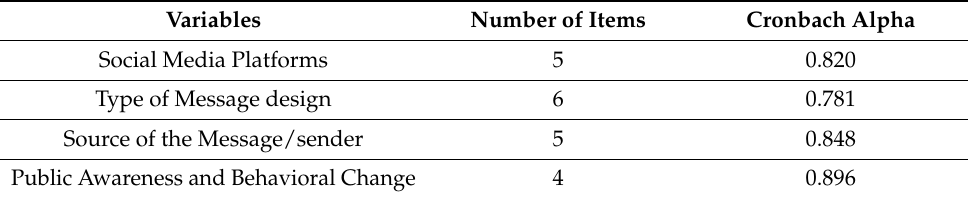
Table 2. The Cronbach’s alpha coefficients of study variables.